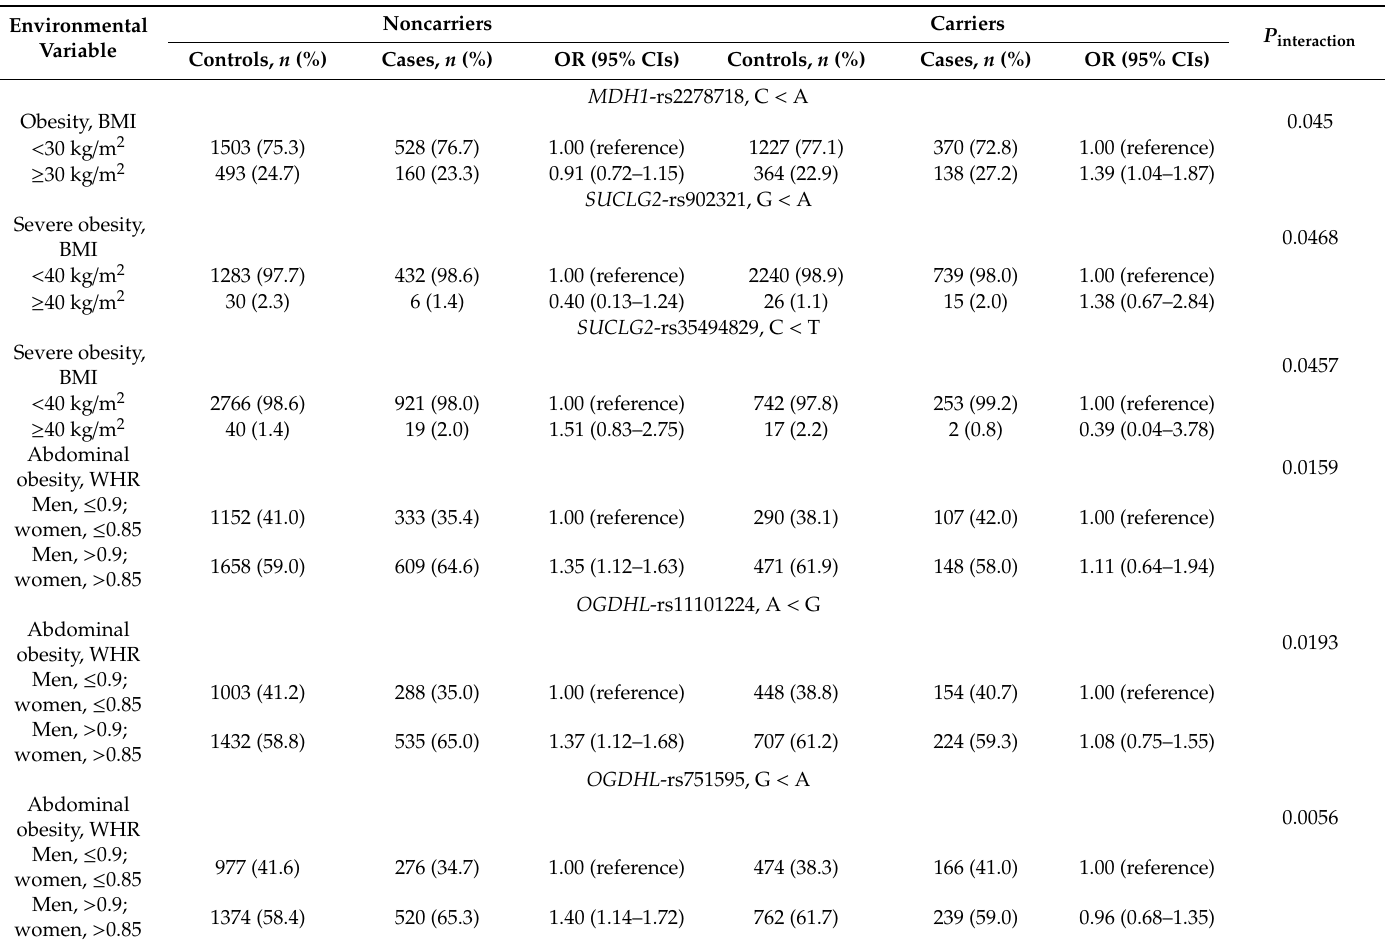
Table 5. Odds ratios (OR) and 95% confidence intervals (CIs) for the contributors of energy balance on the risk of rectal cancer by noncarriers and carriers of the citric acid cycle SNPs showing an interaction p -value under